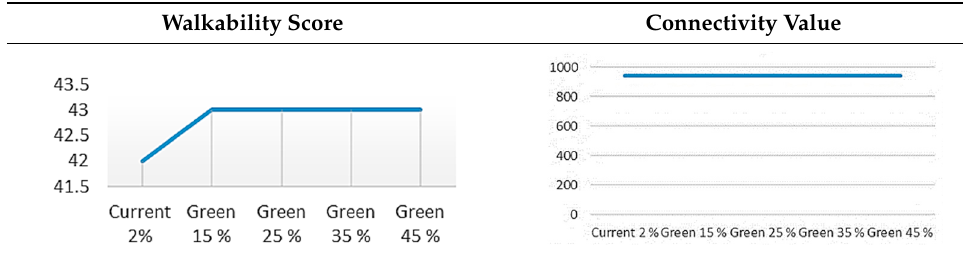
Table 4. Comparative analysis for the walkability and connectivity value.